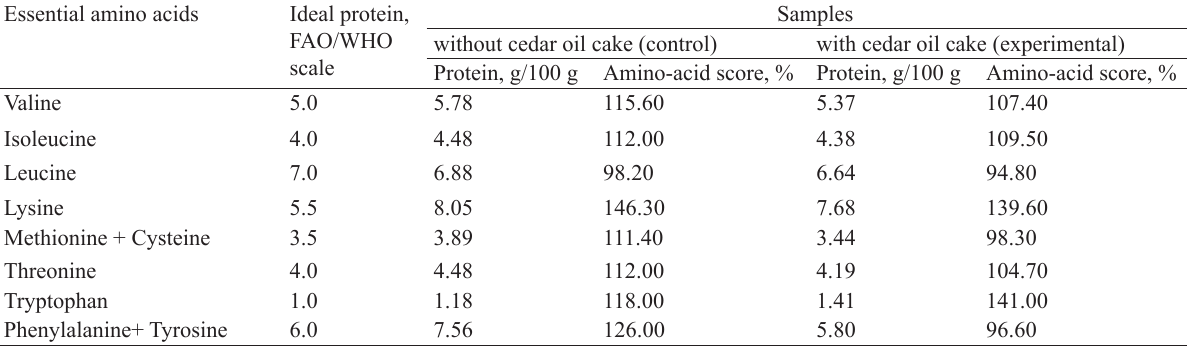
Table 3 Content of essential amino acids in semi-smoked sausages Samples Essential amino acids Ideal protein, FAO/WHO without cedar oil cake (control) with cedar oil cake (experimental) scale Protein, g/100 g Amino-acid score, % Protein, g/100 g Amino-acid score, %